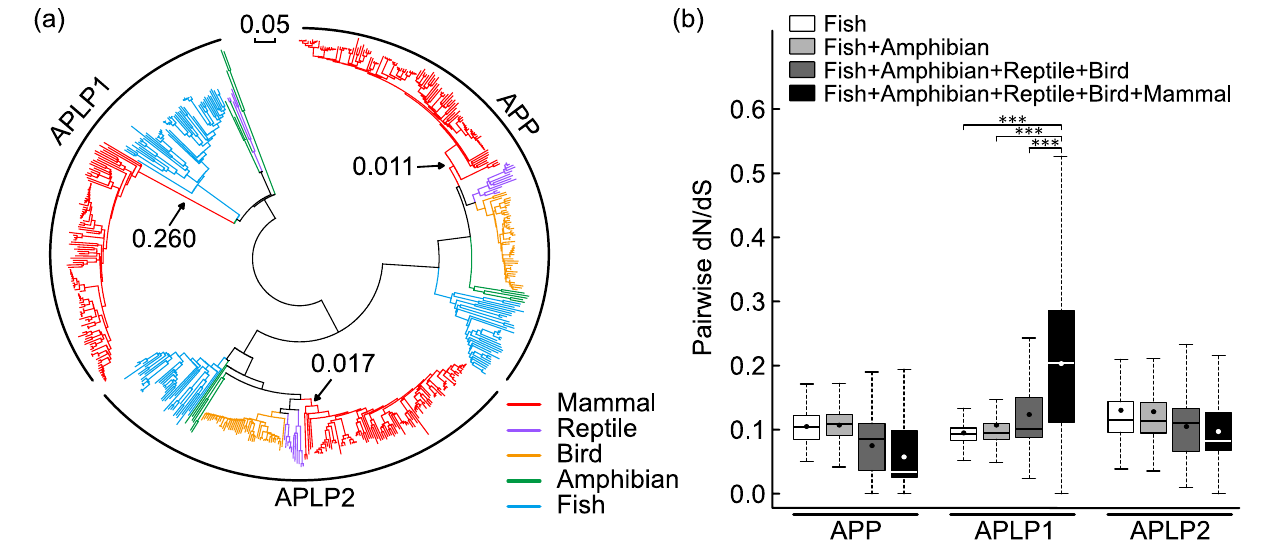
Figure 1. Evolutionary rate analysis for the vertebrate APP family. ( a ) The phylogenetic tree of the vertebrate APP family (nucleotide sequence) was constructed using the neighbor-joining method. Branch colors represent corresponding groups. Arrows point to the common ancestor of the mammalian branch, which shows longer branch length for APLP1 (APP = 0.011, APLP1 = 0.260, APLP2 = 0.017). ( b ) Pairwise dN/dS analysis of the represented groups in the vertebrate APP family. Dots indicate the mean of each dN/dS value. dN/dS was significantly larger for APLP1 when including mammalian clade while no such trend was observed for APP/ APLP2 (***P-value <